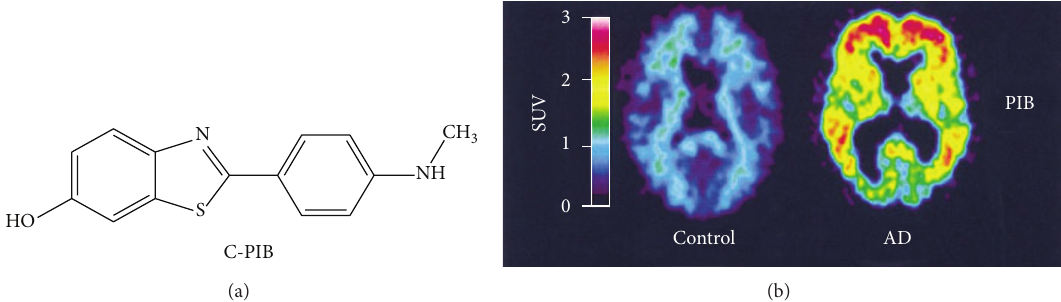
Figure 5: PET imaging of human AD brain using [ 11 C-] PIB [12]. PIB standardized uptake value (SUV) images show a marked difference between PIB retention in AD patients and healthy control subjects. PET images of a 67-year-old healthy control subject (left) and a 79-year-old AD patient. The left column shows lack of PIB retention in the entire gray matter of the healthy subject.